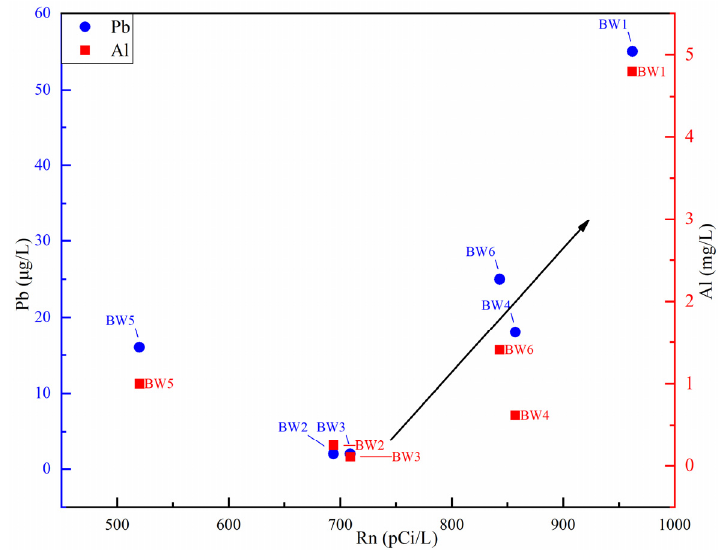
Figure 9. Relationship between Pb, Al, and Rn in Boiling-Wells water.